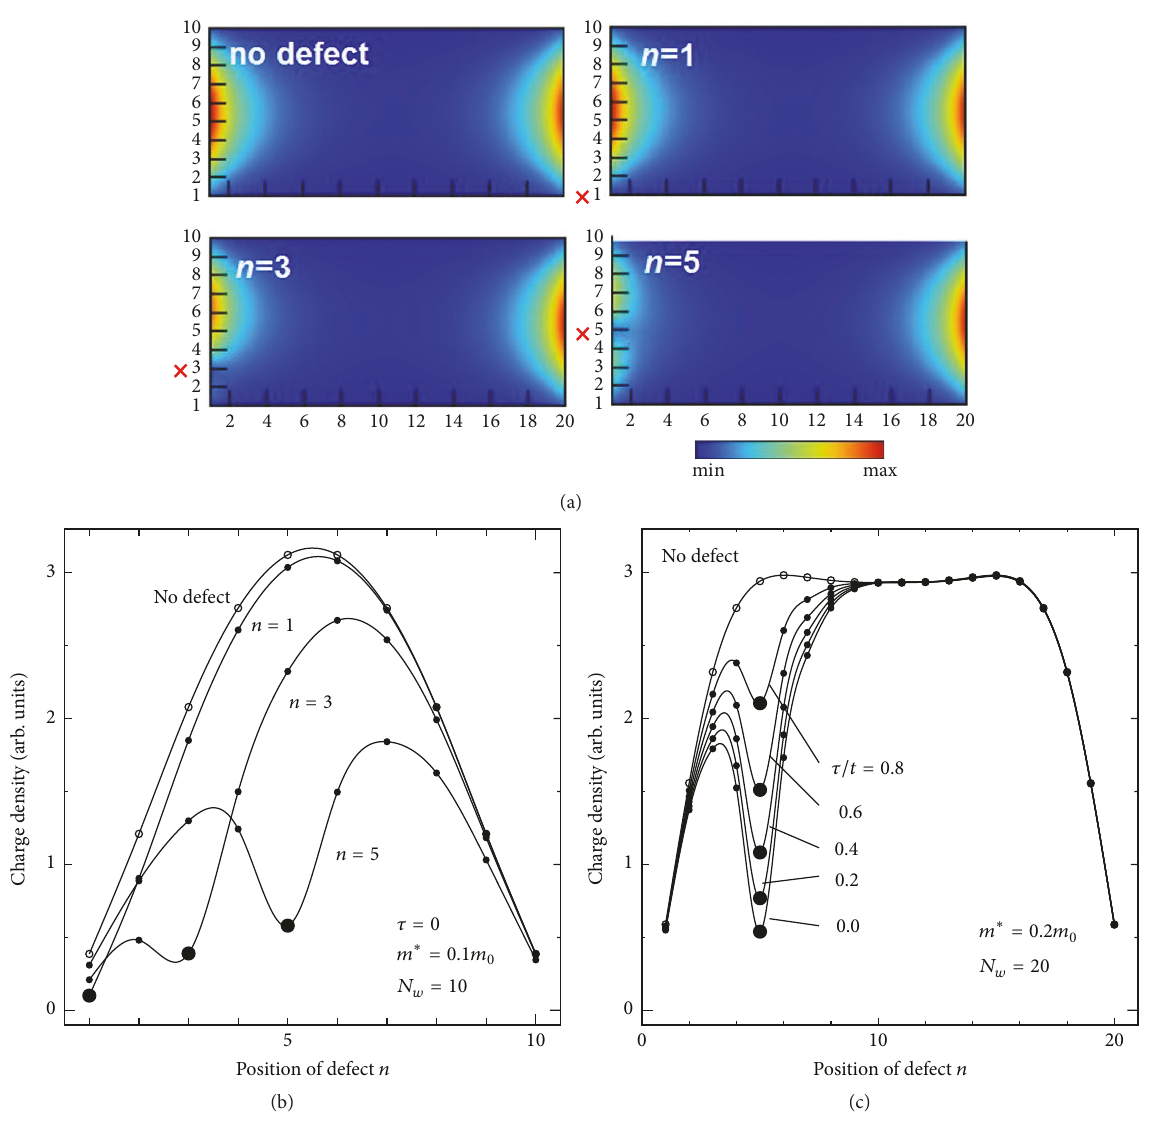
Figure 4: (a) Charge densities calculated for structures without defect and with a defect at the first, third, and fifth positions, respectively. (b) Charge densities along the interface between the cathode and conductor. The large dots indicate the position adjacent to the defect. In (a) and (b), we set 𝑚 ∗ = 0.1𝑚 0 , 𝑁 𝑊 = 10 , and 𝜏 = 0 . (c) Charge densities along the interface between the cathode and conductor for 𝑚 ∗ = 0.2𝑚 0 and 𝑁 𝑊 = 20 and various values of 𝜏 with the defect at the fifth